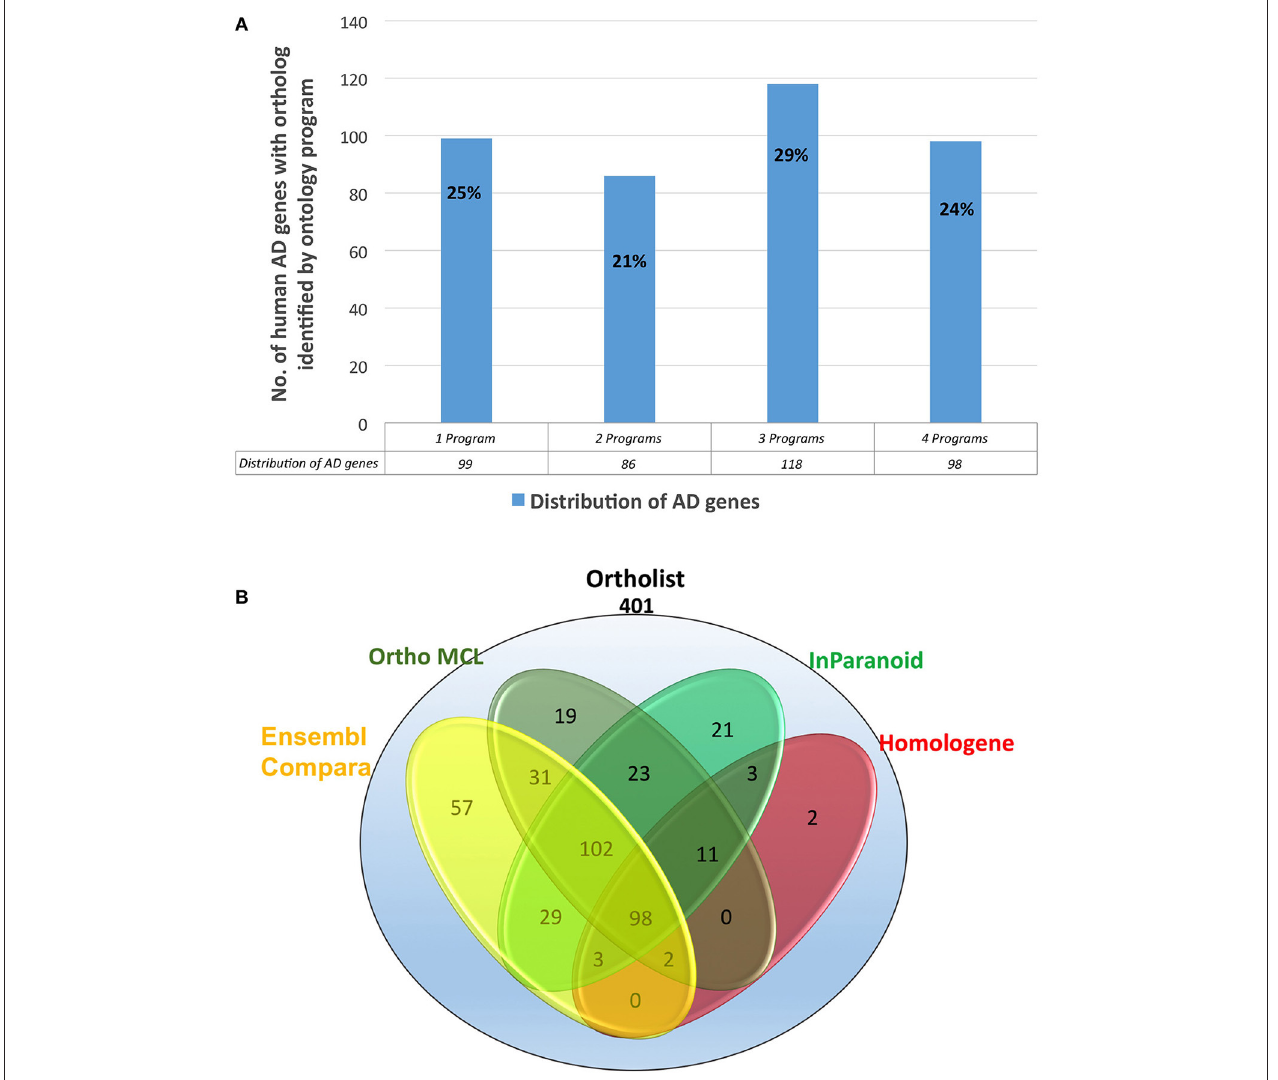
FIGURE 3 | (A) Percentages of the distribution percentages of OrthoList’s 401 AD gene match results among its four unique programs (Ensembl Compara, OrthoMCL, InParanoid, Homologene). (B) Numbers of the distribution of OrthoList’s 401 AD gene match